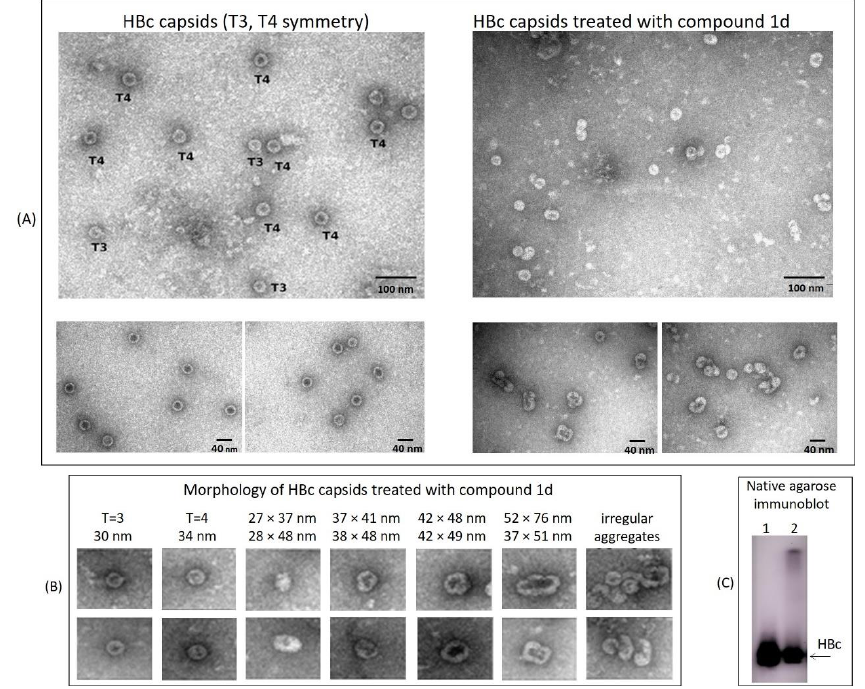
Figure 11. Electron microscopy analysis of particles concentrated from the lysates of BHK-21 cells after treatment with comp. 1d . BHK-21 cells were infected with pSFV1/HBc to allow HBc protein expression. Three hours post-infection, 50 μM comp. 1d was added to cell medium, and the cells were further incubated for 24 h. After incubation the cell lysates were performed and used for ultracentrifugation through 20% sucrose cushion. The pellets containing capsids and high molecular capsid-like structures were resuspended and used for electron microscopy analysis (TEM). ( A ) Electron microscopy pictures of regular HBV core particles of standard T3 and T4 symmetry isolated from untreated cells (on the left) and irregular misassembled core particles isolated from cells treated with comp. 1d (on the right). ( B ) Selected HBc protein assembly products visible by electron microscopy from cells treated with HAP comp. 1d . The approximate particle size was measured as the longer and shorter diameter of the irregular form of the particle. ( C ) Native agarose anti-HBc immunoblot of samples prepared for electron microscopy: line 1—untreated HBc; line 2—HBc